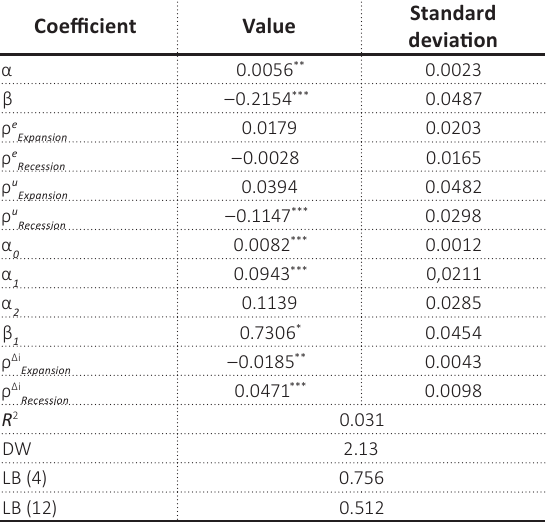
Table 9. Testing results for advanced hypotheses